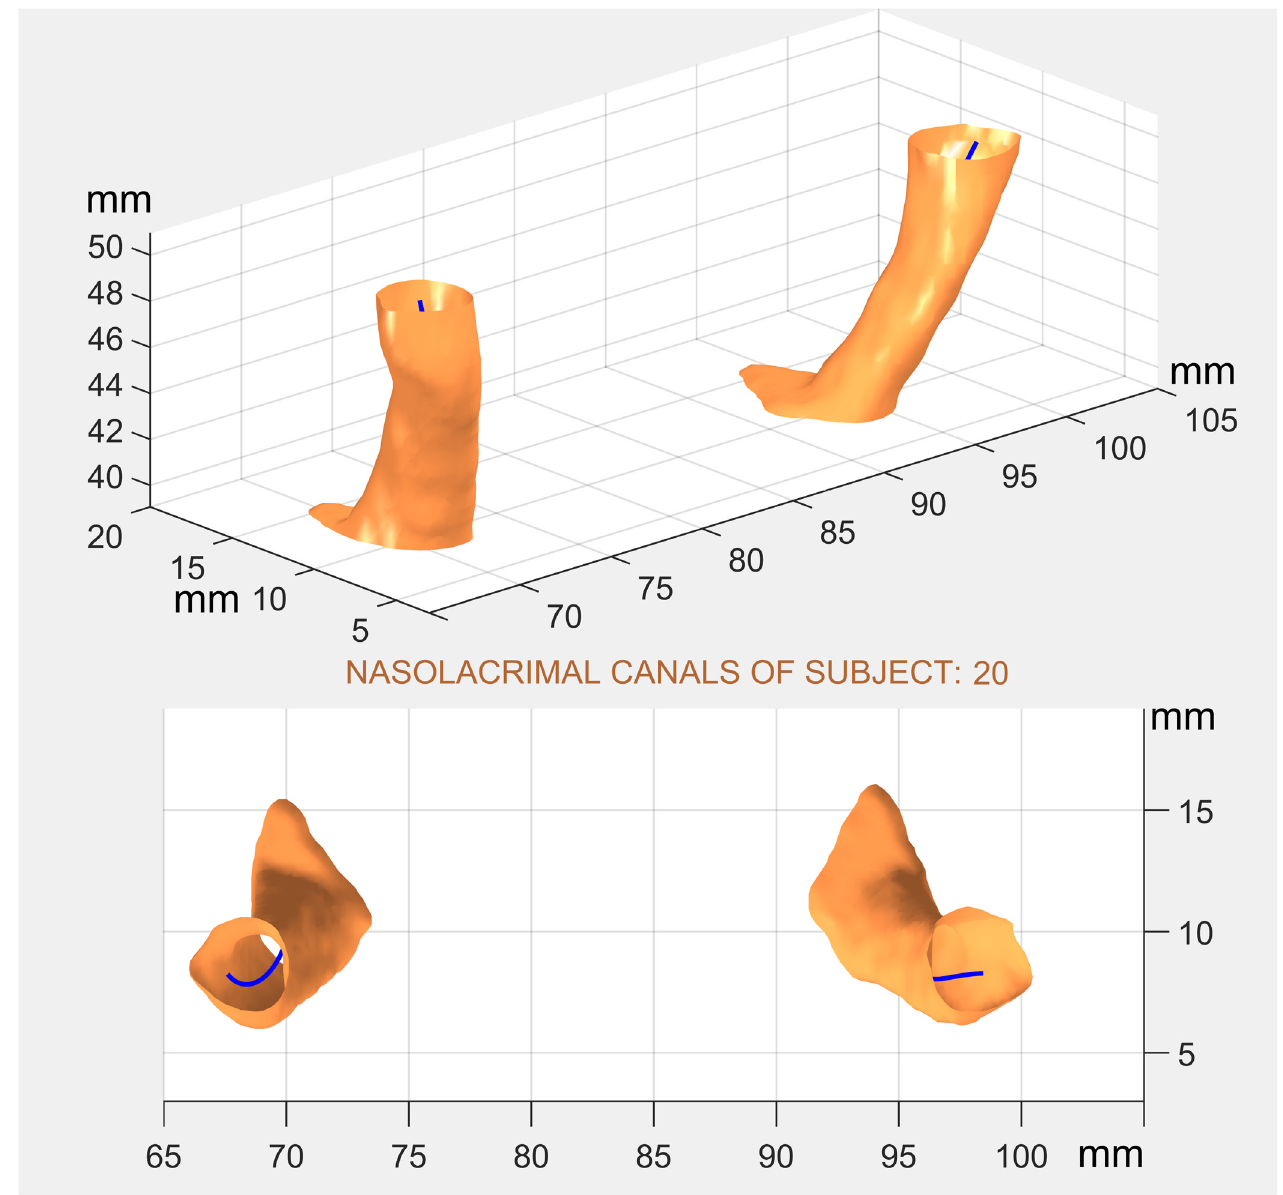
Fig 5. Surface and axis models of NLCs: oblique and overhead views (subject